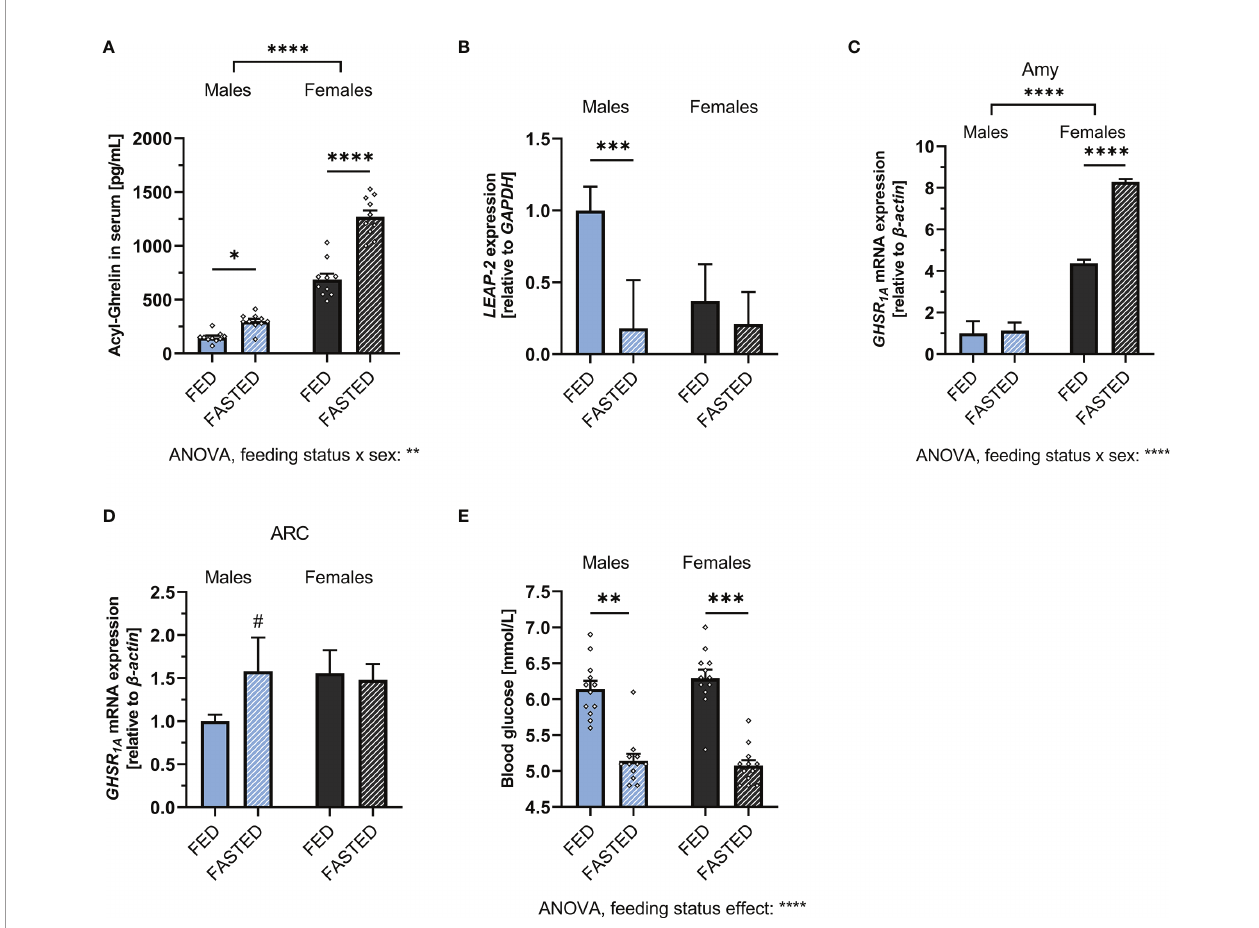
FIGURE 2 | Alterations of the ghrelin axis induced by overnight fasting. Fasting increased circulating acyl-ghrelin levels in both males and females (n = 10 per group) (A) . Hepatic LEAP-2 mRNA expression was signi fi cantly decreased after fasting in males, but not females (n = 10 per group) (B) . GHSR 1A mRNA expression was increased in the amygdala of fasted females, but not males (n = 10 per group). (C) . A trend for upregulation of GHSR 1A expression in the ARC was detected in fasted males, but not females (n = 12 per group) (D) . Overnight fasting decreased blood glucose in both males and females (n = 12 for each group) (E) . All data are presented as mean ± SEM. # p < 0.1, * p < 0.05, ** p < 0.01, *** p < 0.001, **** p < 0.0001 compared with respective controls. GHSR 1A , ghrelin receptor; LEAP-2, liver-expressed antimicrobial peptide 2; GAPDH, glyceraldehyde-3-phosphate dehydrogenase (housekeeping gene); Amy, Amygdala; ARC, arcuate